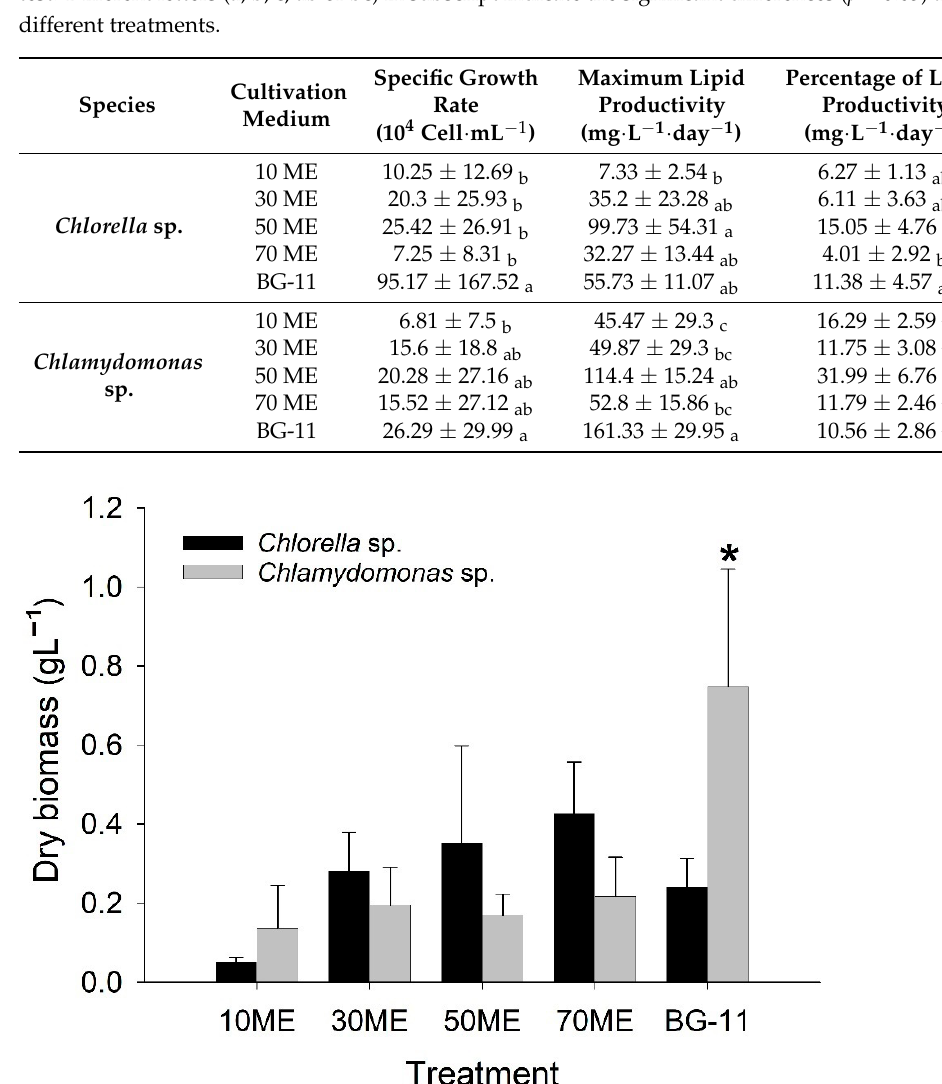
Figure 4. Dry biomass of microalgae species grown in different dilution concentrations of malting effluent. The bars (black bars: Chlorella sp. and grey bars: Chlamydomonas sp.) represent mean biomass, and errors refer to standard deviation. The level of significance is from two-sample t -test statistics (* p < 0.05).